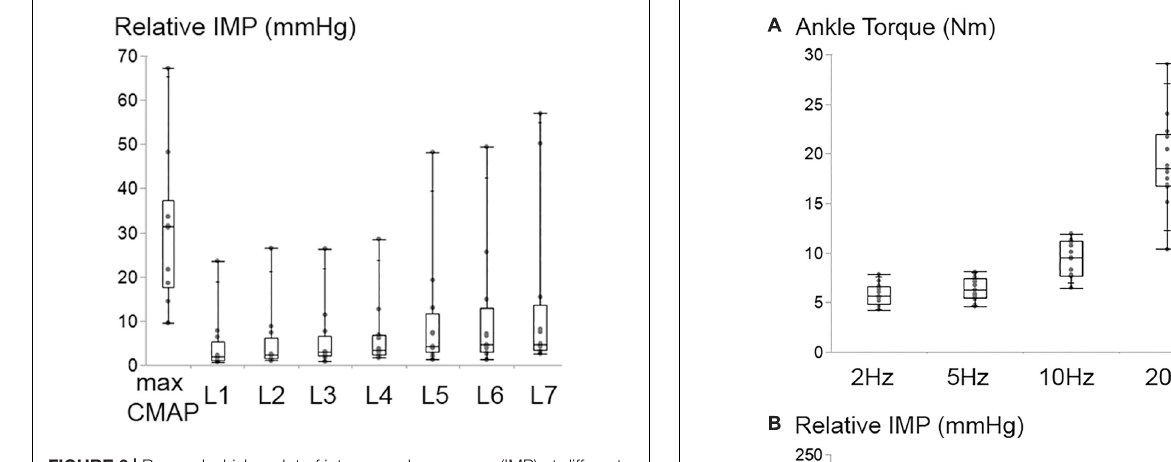
FIGURE 6 | Box and whisker plot of intramuscular pressure (IMP) at different stimulation intensity levels. The stimulation level that generates maximum CMAP and level 1 (L1) refer to the maximum and minimum intensity applied, respectively. The IMP changed significantly with the increasing stimulation amplitude ( P < 0.001).